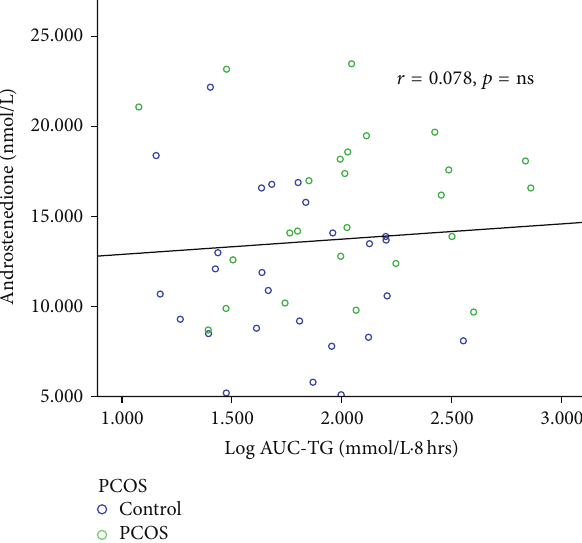
Figure 6: Correlation between AUC-TG and FAI.